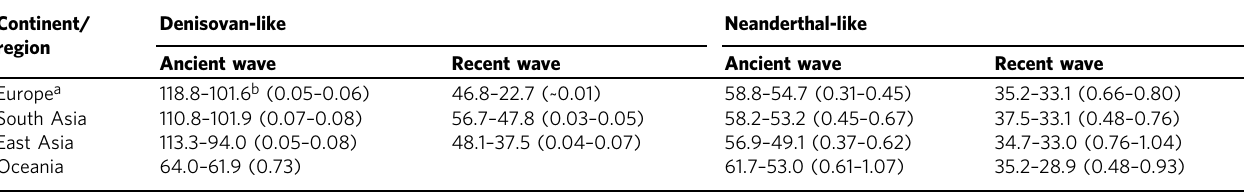
a Results of Iberian populationsin Spain (IBS) did notsupport the two-waveDenisovan-like introgression model, sothe Denisovan-likeintrogression model of Europeans did notsupport the results of IBS (Supplementary Note 5.2). (Supplementary Note 5.2). Introgression proportion is displayed as a percentage